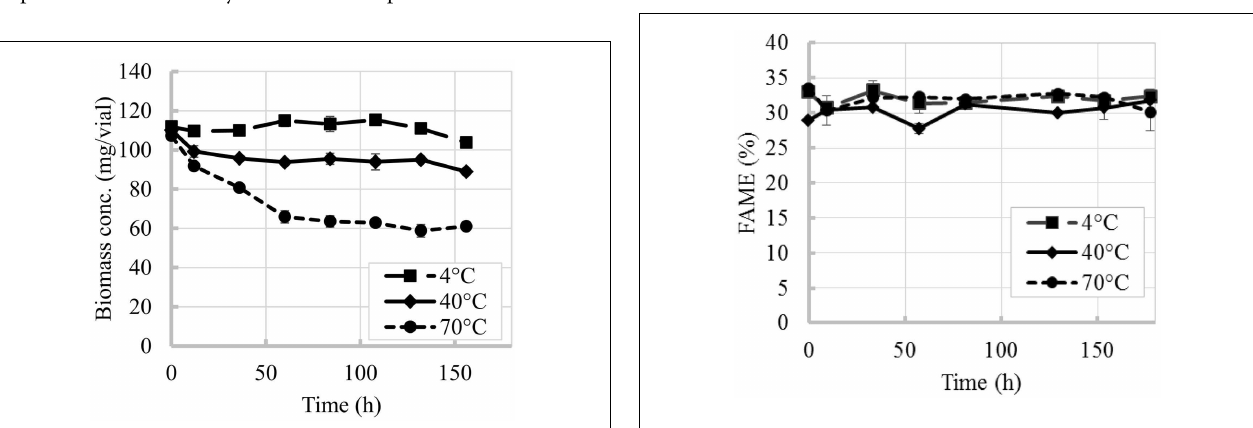
FIGURE 1 |Time evolution of N. salina biomass content at different temperatures . Error bars represent SD from three independent experiments. SD not visible is overlapped with the symbols.